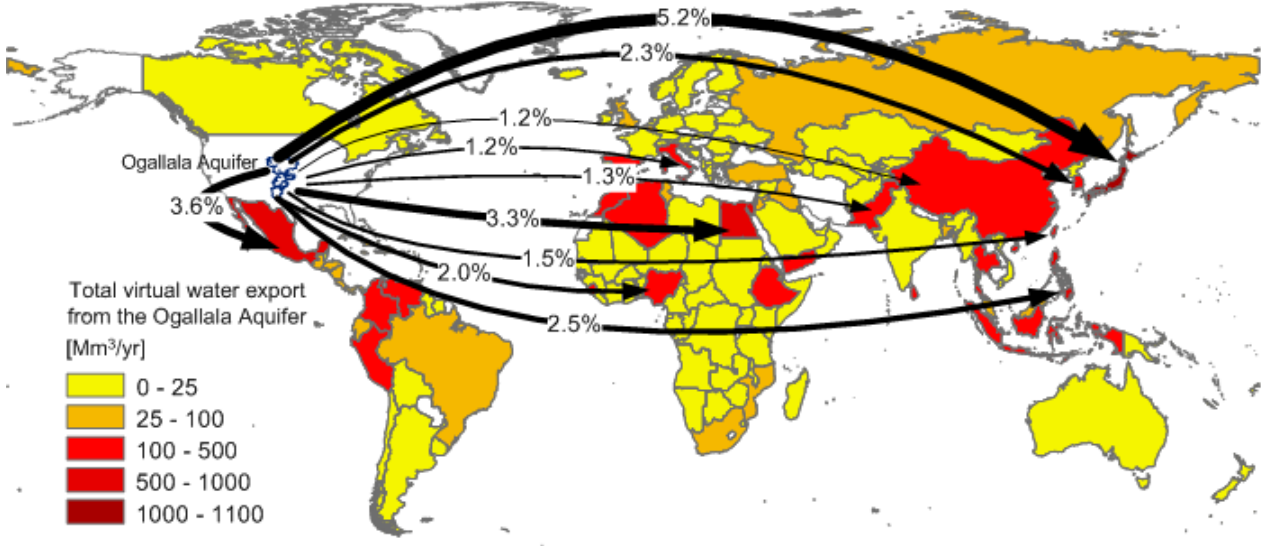
Fig. 7. Major destinations of wheat-related virtual water exports from the Ogallala area in the USA (1996–2005). About 58% of the total water footprint of wheat production in the area is for wheat consumption in the USA and 42% is for export to other nations. Only the largest exports ( > 1%) are